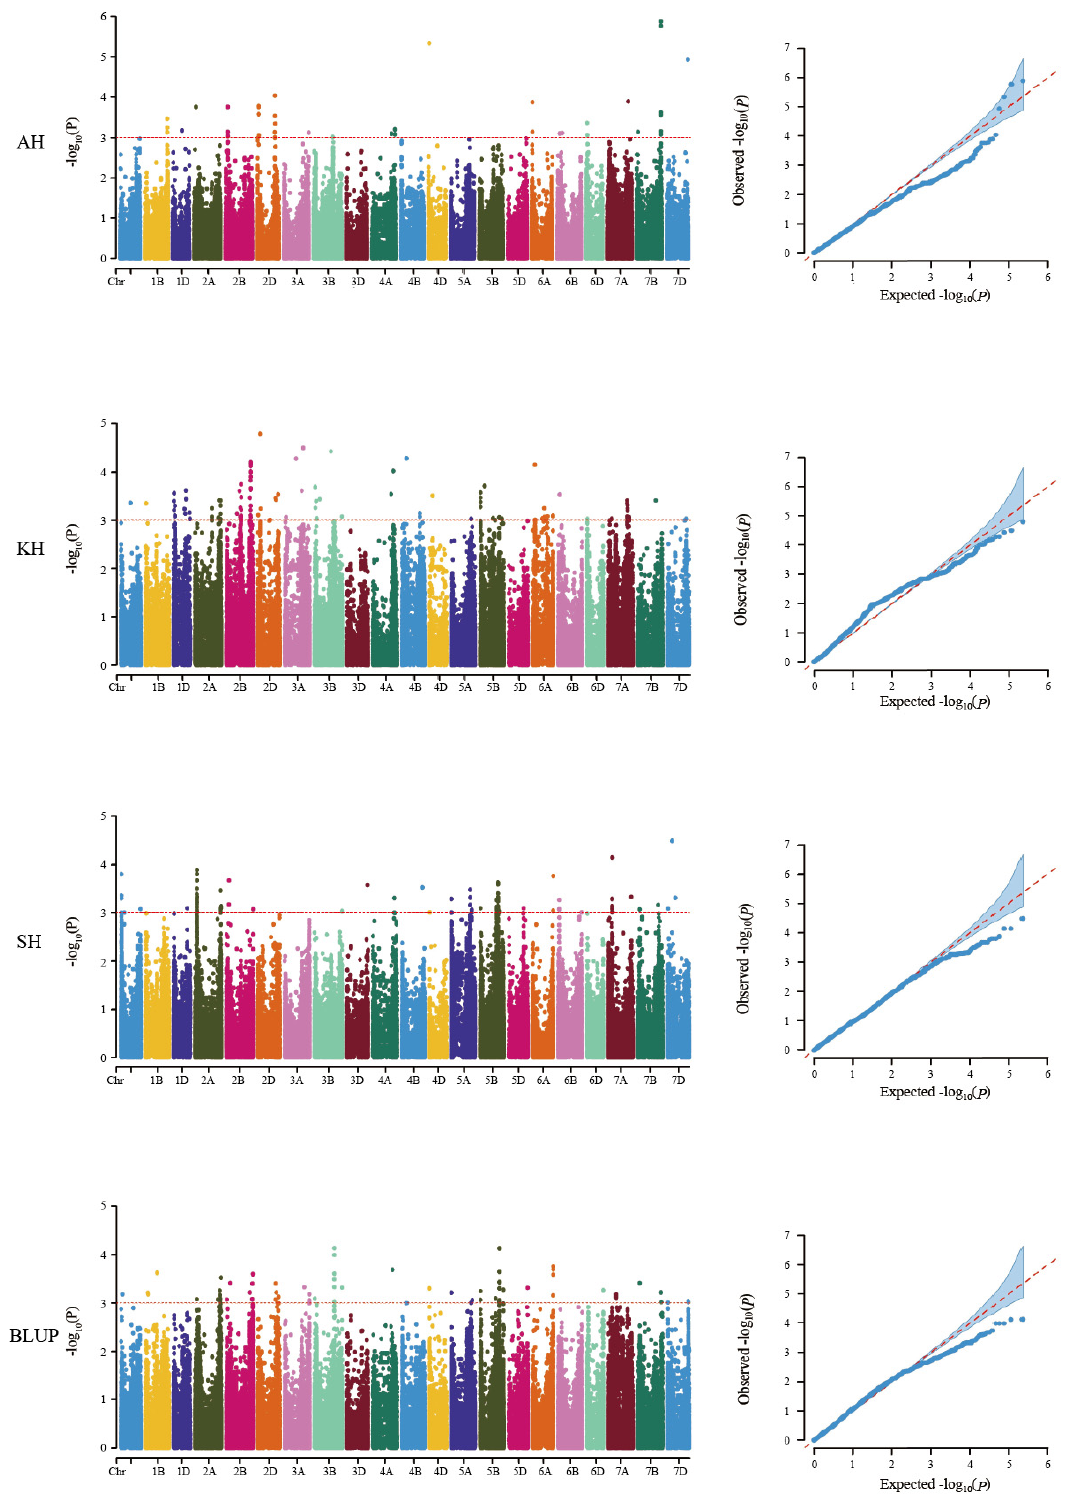
Figure 2. Manhattan and Q-Q plots for RS content in the association population under three locations. AH, KH, and SH represent the planting location of Yuanyang, Kaifeng, and Shangqiu, respectively, while BLUP represents the BLUP values of the three environments. The red, horizontal dotted line in Manhattan plots indicates the significance threshold line ( − log 10 P = 3). The red dotted lines in Q-Q plots represent the theoretical values of observed − log 10 P equal to expected − log 10 P . The blue shades indicate the theoretical threshold.